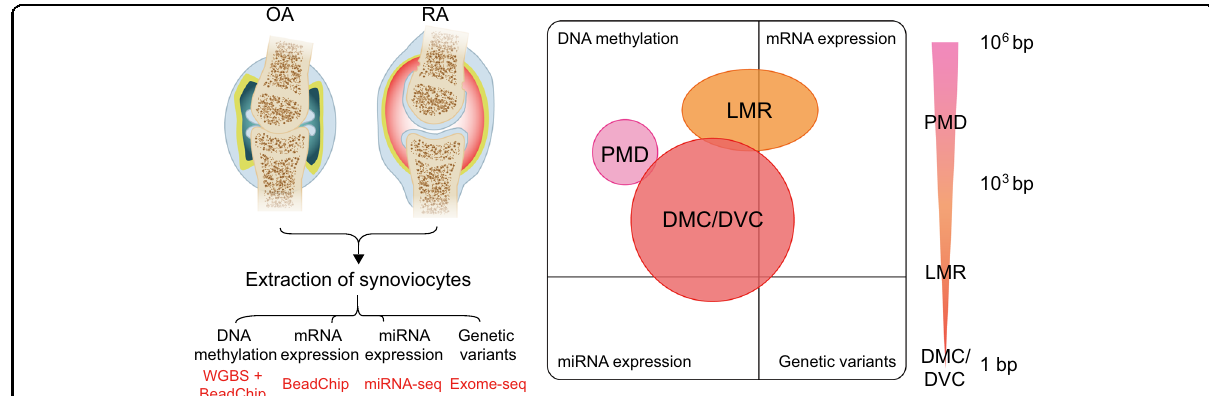
Fig. 1 An overview of experimental procedures with RA and OA. The types of data produced in this experiment are DNA methylation, mRNA expression, miRNA expression, and rare genetic variants. Differentially methylated regions (DMR) were separately investigated according to their sizes. The stretching ellipse represents the resolution of each type of DMRs identi fi ed. WGBS whole-genome bisul fi te sequencing, PMD partially methylated domain, LMR low-methylated region, DMC differentially methylated CpG, DVC differentially variable